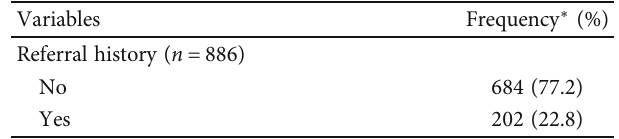
Table 1: Reproductive history of mothers admitted to selected hospitals in North Shewa, Central Ethiopia, from 2012 to 2017